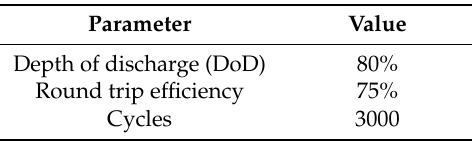
Table 4. Technical parameters of the standard battery (SB).